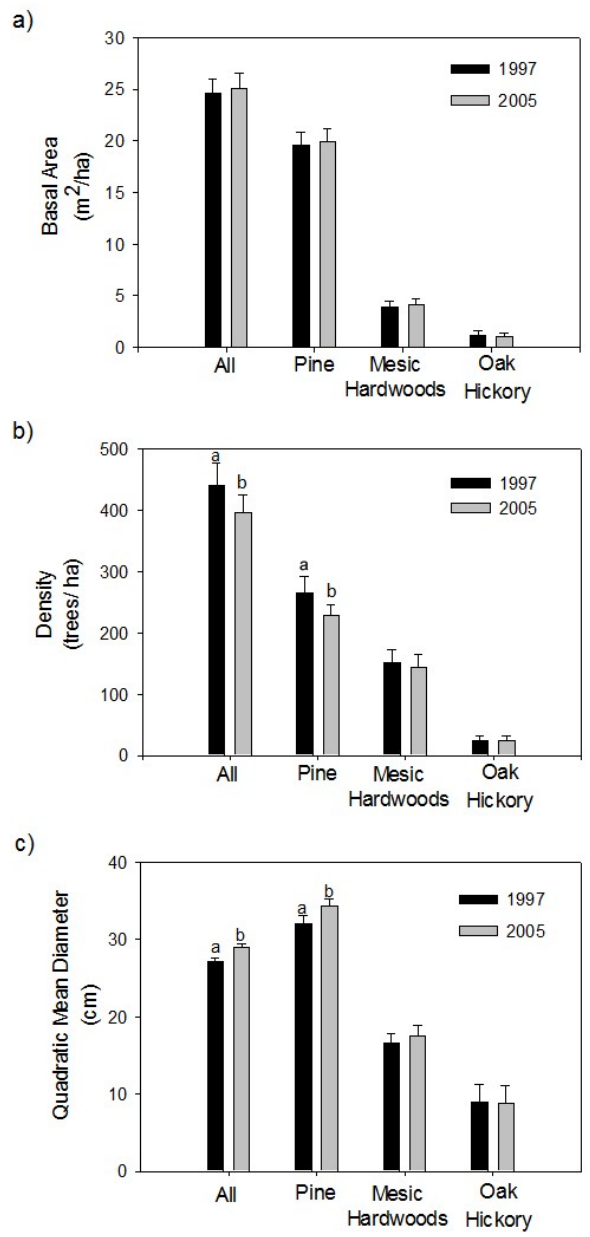
Figure 3. Effects of repeated growing season prescribed fire on ( a ) basal area, ( b ) density, and ( c ) quadratic mean diameter of overstory trees ( ≥ 11.7 cm) in mixed pine–hardwood forests of the Piedmont National Wildlife Refuge near Macon, Georgia, USA. Letters represent significant differences ( p ≤ 0.05) for post hoc Tukey’s Tests on the main effect of time between 1997 and 2005. There were no differences among burning windows for density or basal area of all trees or species groups (Table 3). Mesic hardwoods’ quadratic mean diameter differed among windows ( p < 0.001), but there was a significant block by window interaction ( p < 0.001) (Table 3). Significant two ‐ way interactions included time and window for mesic hardwood basal area ( p = 0.05), block and window for mesic hardwood basal area ( p = 0.013) and density ( p = 0.03). Three ‐ way interactions among time, block, and window for oak ‐ hickory quadratic mean diameter were also significant ( p =